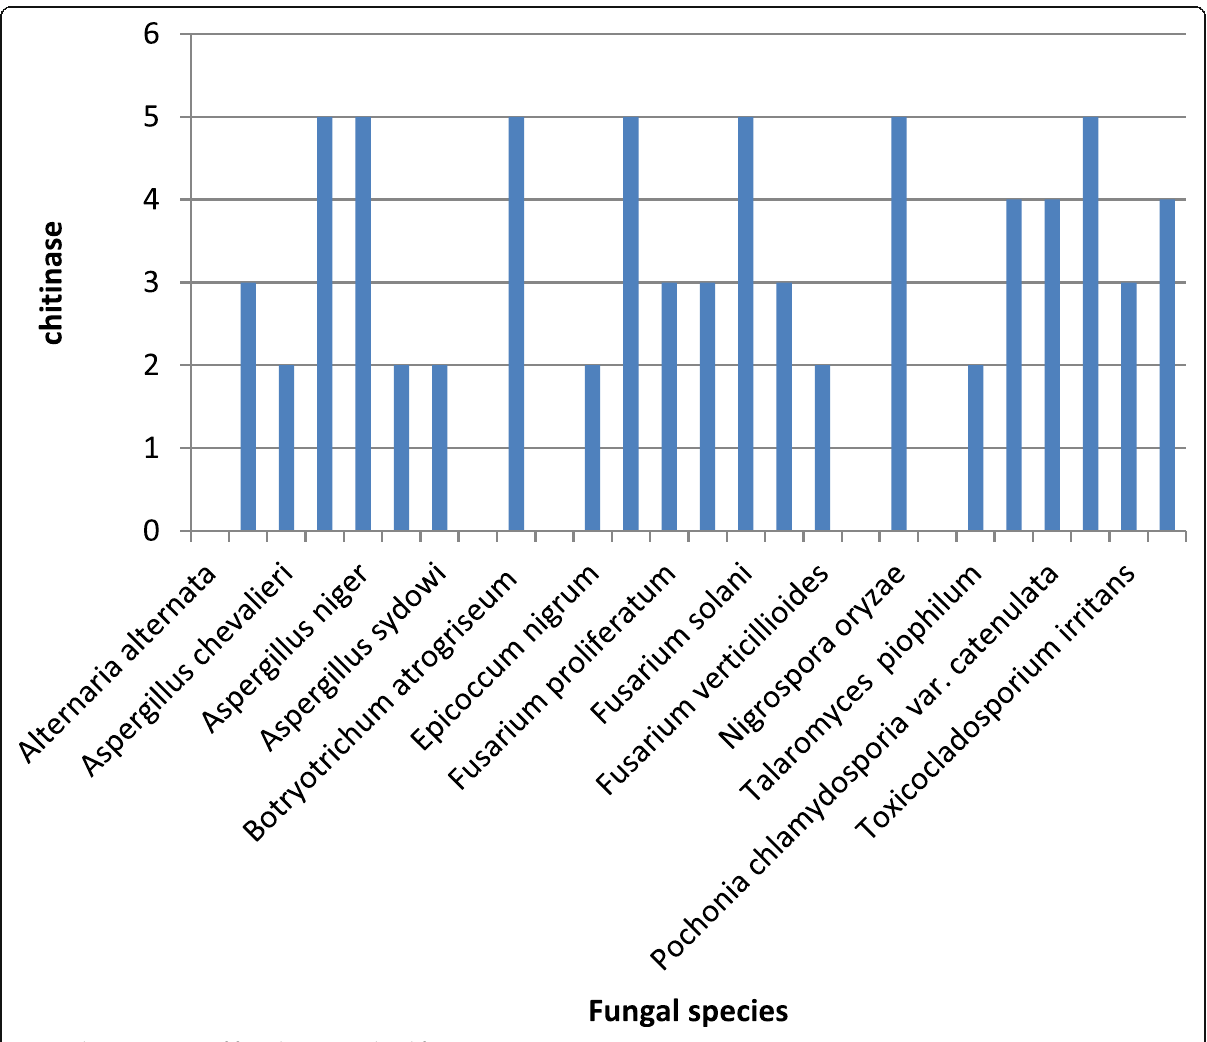
Fig. 4 Chitinase activity of fungal species isolated from insects